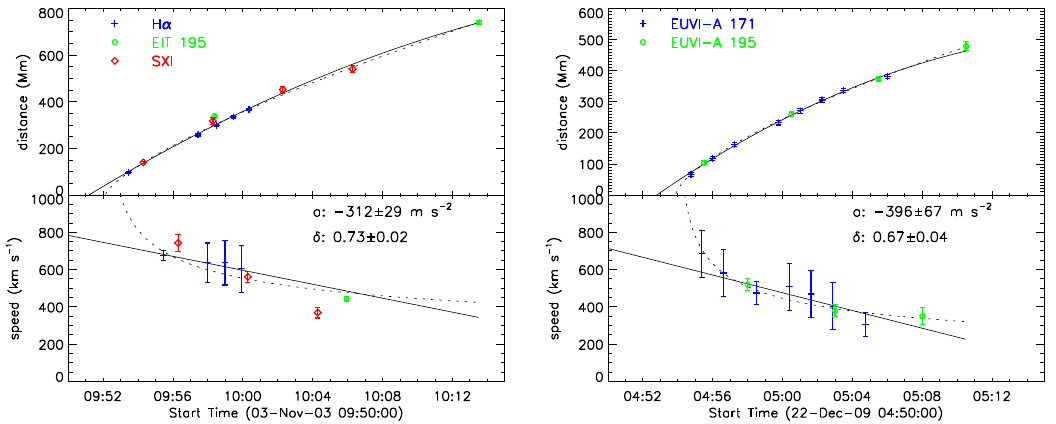
Figure 23: Kinematics of decelerating coronal waves. Left : distance-time ( top ) and velocity-time plot ( bottom ) of the coronal wave of 2003 Nov 3, derived from a combination of H α , SOHO/EIT and GOES/SXI wavefronts. The distances are fit with a second-degree polynomial ( full line ) and with a power-law ( dashed line ) (adapted from Warmuth et al. , 2005). Right : the decelerating coronal wave of 2009 Dec 22 imaged with STEREO/EUVI at 171 and 195 ˚A. Note that the power-law fits the kinematical curve better than the second-degree polynomial (adapted from Warmuth and Mann,